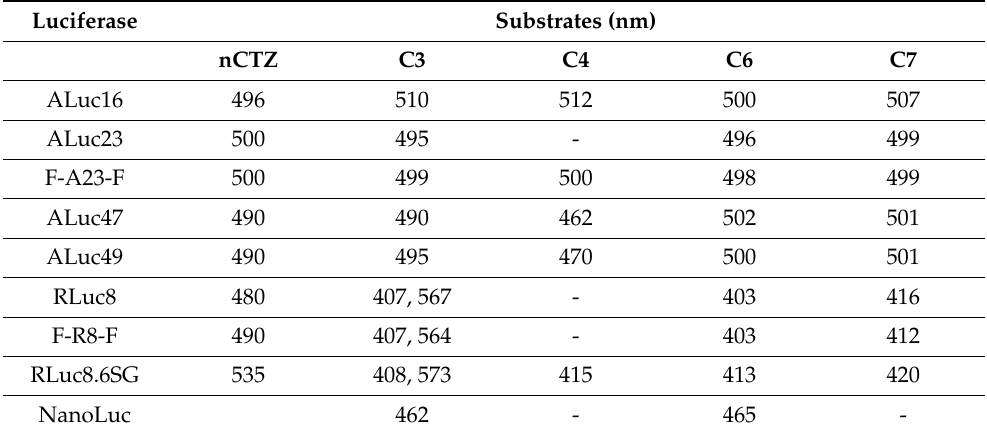
Table 1. The maximal BL wavelengths ( λ max ) of various marine luciferases in the presence of the CTZ analogues C3 , C4 , C6 , and C7 . Substrates